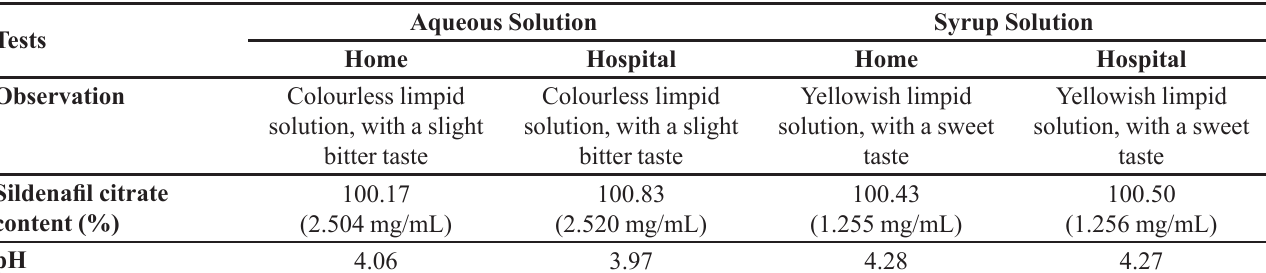
TABLE I - R esults of physicochemical determinations after in-use stability studies